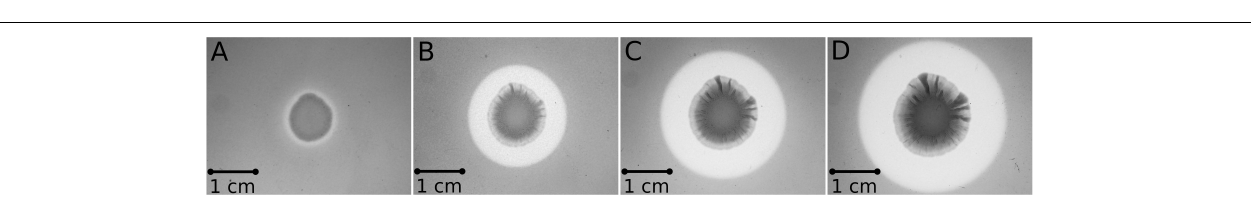
FIGURE 6 | PCL plate clearing assay with the E. coli BL21(DE3)(pET20b:SM14est) heterologous host, incubated at 28 ◦ C after (A) 1 day; (B) 2 days; (C) 3 days; (D) 4